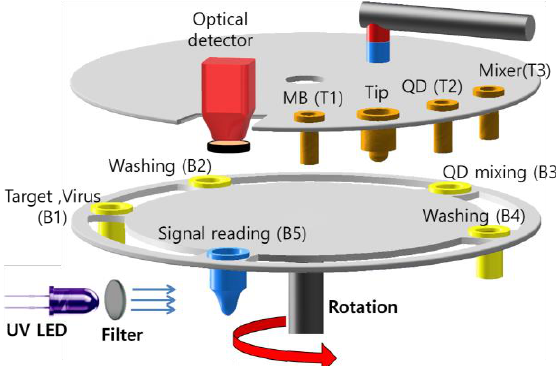
Scheme 1. Schematic illustration of sandwich immunoassay-based virus detecting system applied on the movable chip.